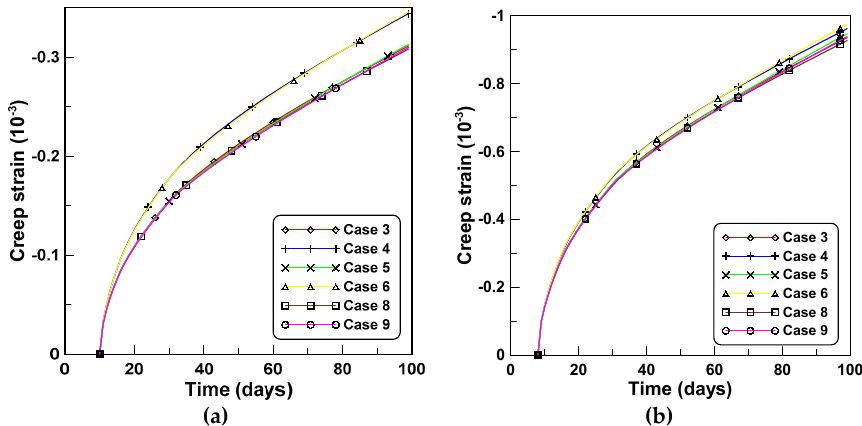
Figure 10. Creep strains by six constitutive formulations: ( a ) analysis of case A and ( b ) analysis of case B.